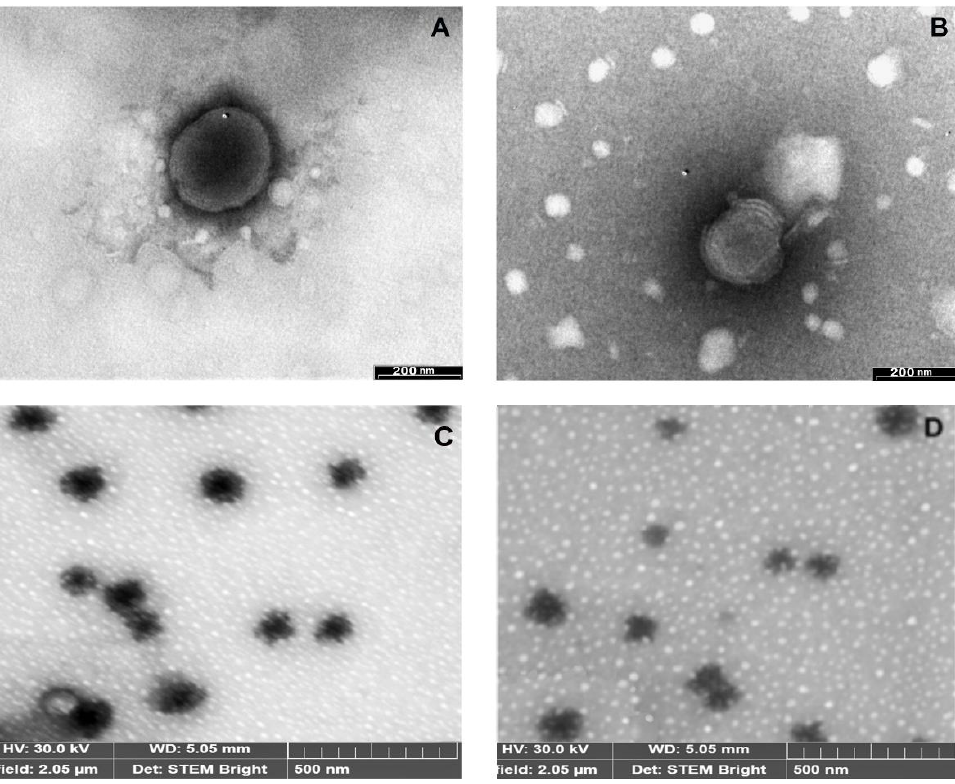
Figure 4. Representative TEM (top) and SEM (bottom) micrographs of SL2 ( A , C ) and DL2 ( B , D ) liposomal formulations (see Table 3 for liposomal formulation composition).